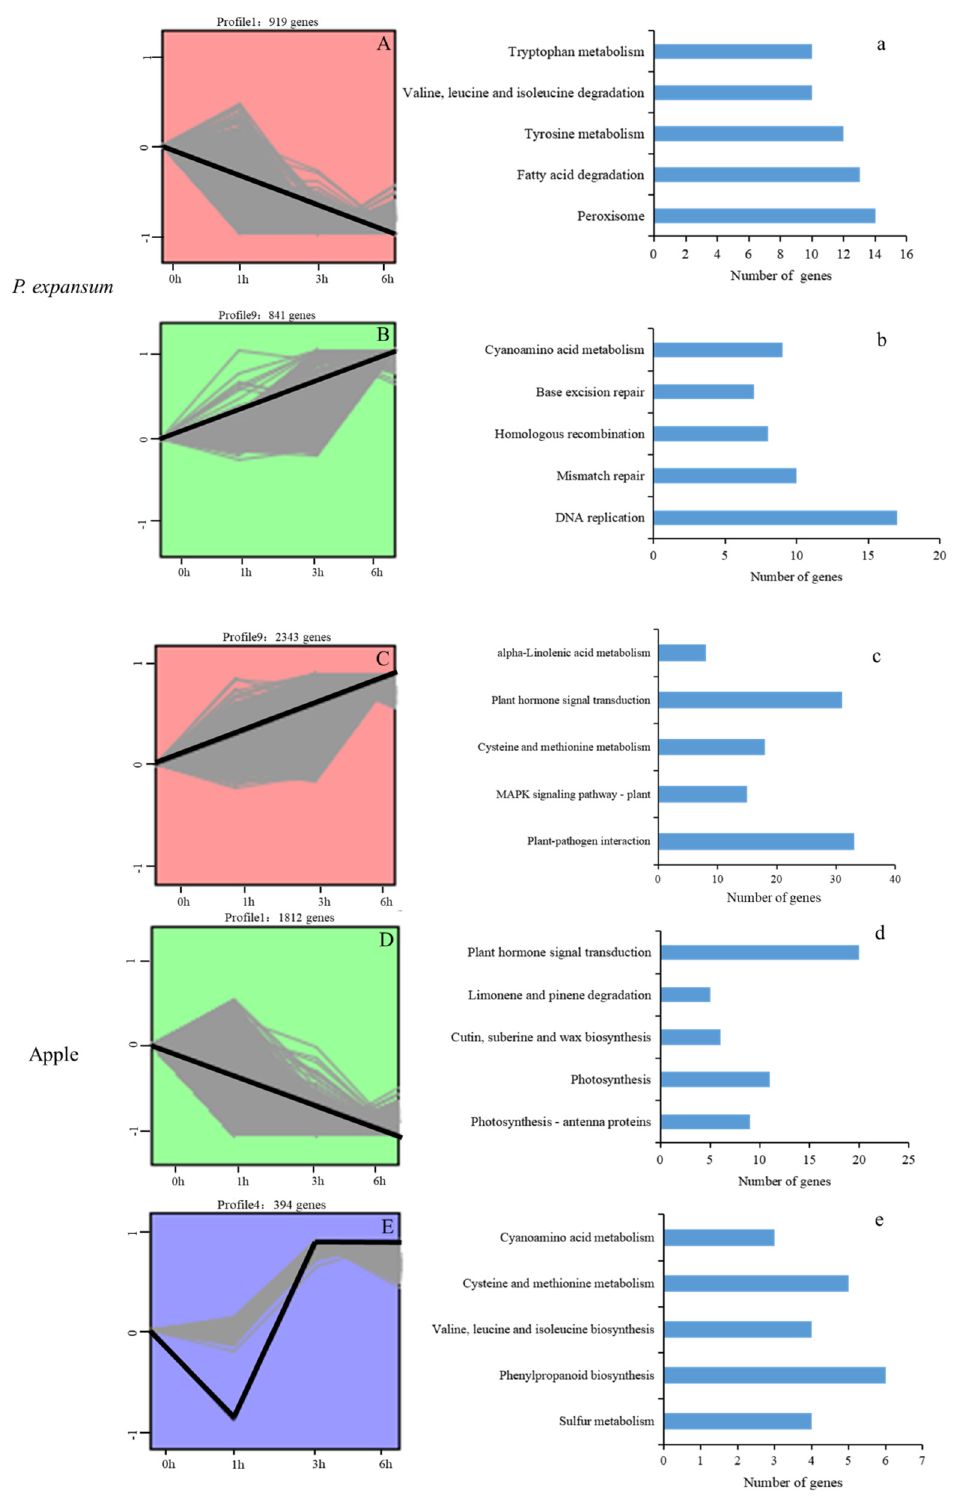
Figure 4. Patterns of gene expressions ( A – E ) and the top 5 KEGG enrichment pathway categories ( a – e ) of the DEG profiles of P. expansum and apple which were significantly different from the reference set (DEGs at 0 hpi) combined across three time points (1, 3, and 6 hpi). The light grey lines in each figure represent the expression pattern of an individual gene, while the black line represents the average expression pattern of all the genes combined. The number of genes represented in each profile is indicated above each figure.